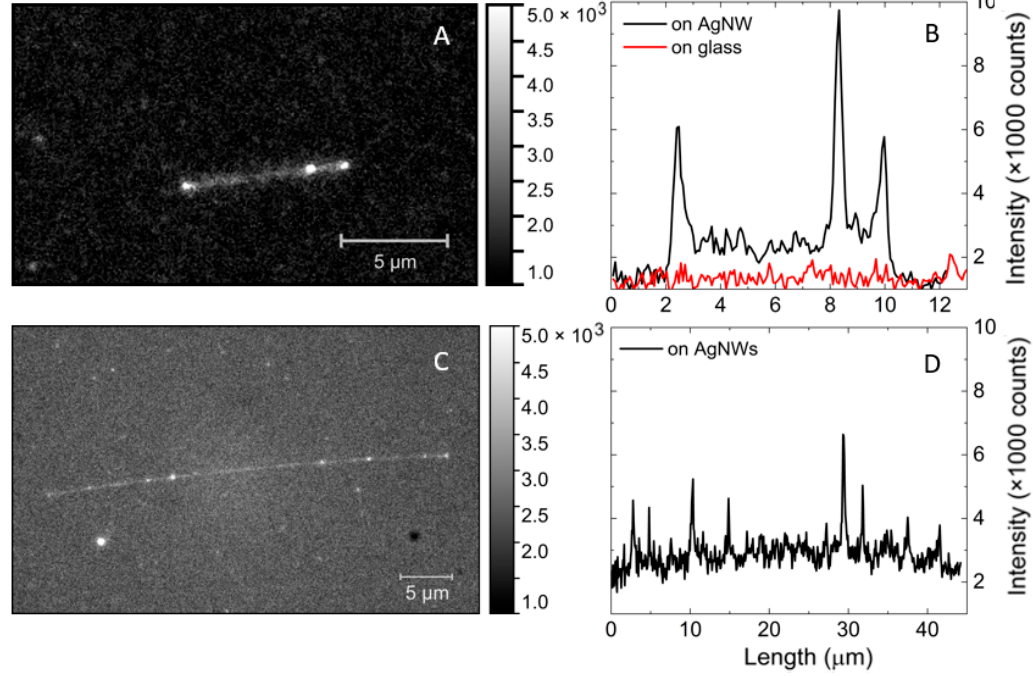
Figure 2. Fluorescence intensity maps of mCherry mixed with AgNWs (on the left ) and cross-section along the silver nanowire and on glass (on the right ). ( A , B ) sample with mCherry solution 0.5 µg/mL with AgNW, ( C , D ) sample with solution of single mCherry with AgNW.